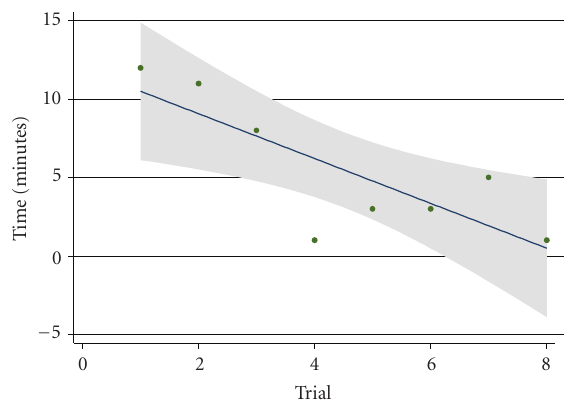
Figure 1: Needle navigation time versus trial number. The time required to accurately position the needle tip at the aortic root decreased significantly over the course of the trial, from 12 minutes with the first attempt to one minute with the last. P = . 003, F -test.